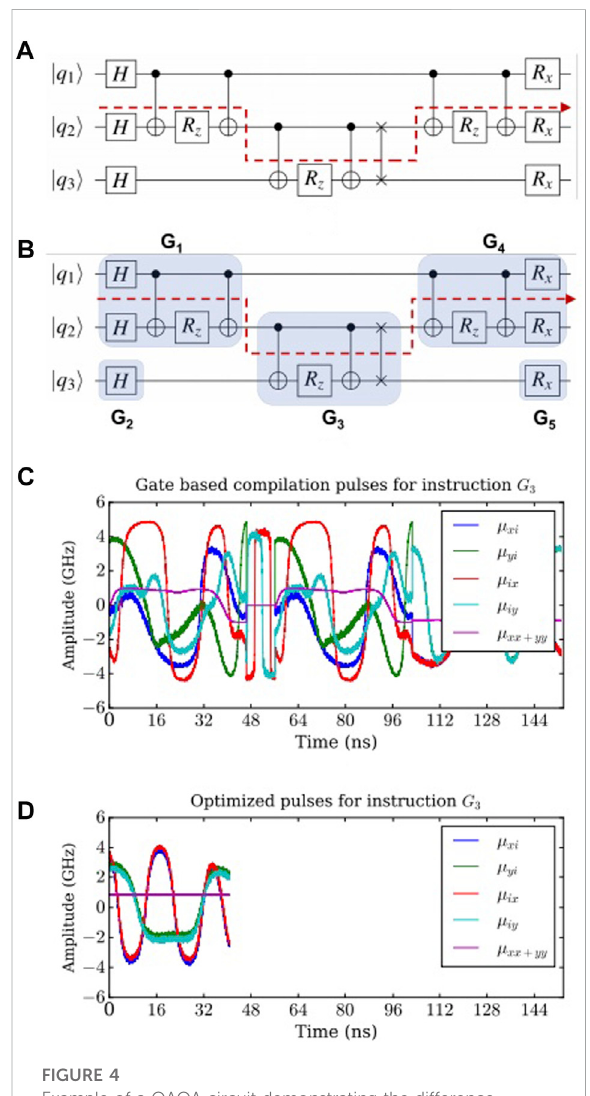
FIGURE 4 Example of a QAOA circuit demonstrating the difference between gate-based compilation and the novel compilation methodology. (A) Standard circuit (red arrow indicates the critical path). (B) Circuit with aggregated instructions. (C) Standard compilation pulses for G3. (D) Aggregated compilation pulses for G3. Each line represents the intensity of a control fi eld. The pulse sequence in (D) is much shorter in duration and easier to implement than that of (C) .